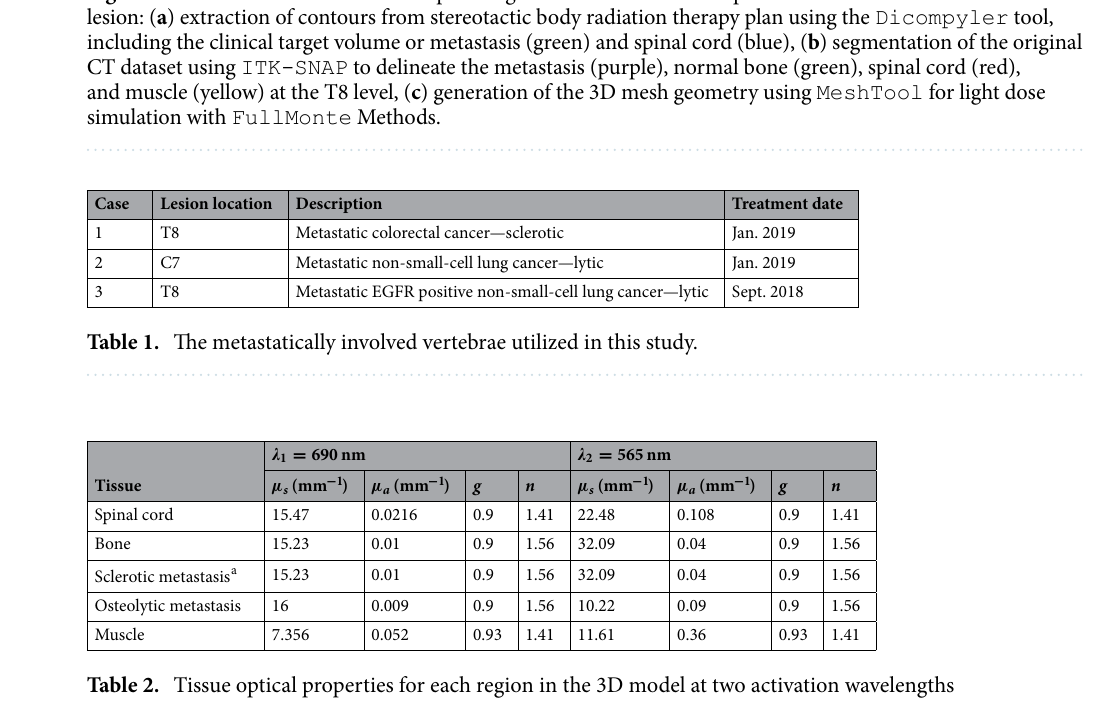
a Assumed to have similar tissue optical properties as the bone.